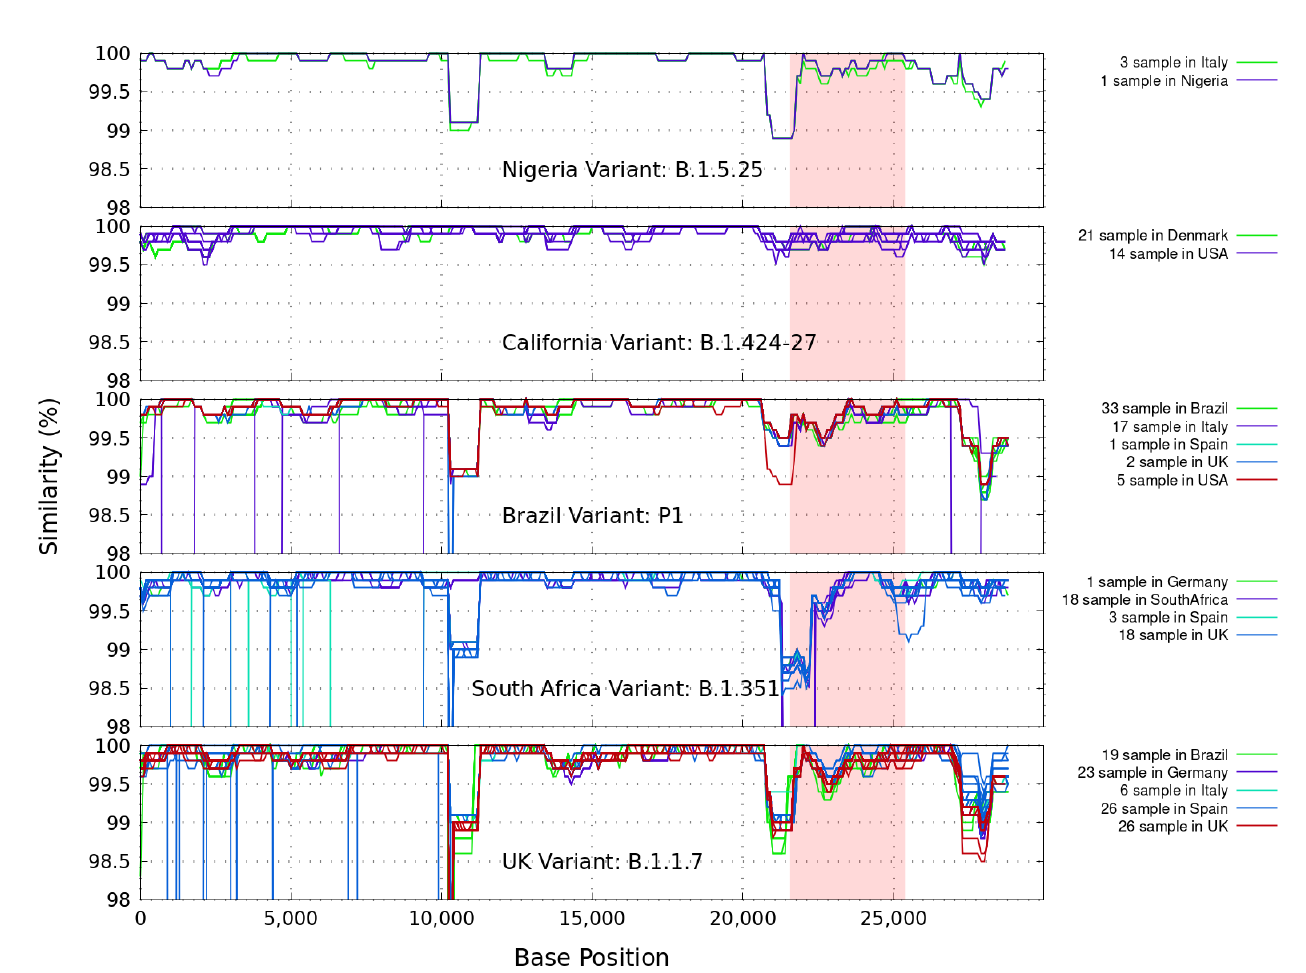
Figure 1. Genetic similarity plot between the query sequence SARS-CoV-2 Wuhan-Hu-1 and several representative full- length genome sequences grouped by variants as found in broad geographical regions, for different numbers of samples, and collected between 1 November 2020 and 1 March 2021. A sliding 1000 base pair (bp) window in steps of 100 bp is used. In red is the genomics region encoding the spike (S-protein). The samples shown for a given country correspond to data from a given variant. For example, the difference between the 33 and 19 samples from Brazil means that 33 of the samples are in correspondence with the Brazilian variant P1, and the other different 19 samples are also from Brazil, but they contain the UK variant